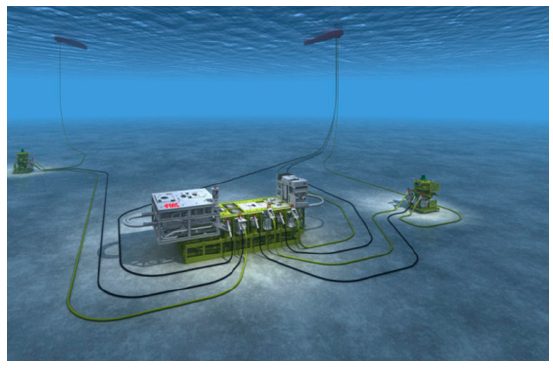
Figure 4. Petrobras Marlim oil and gas fields.